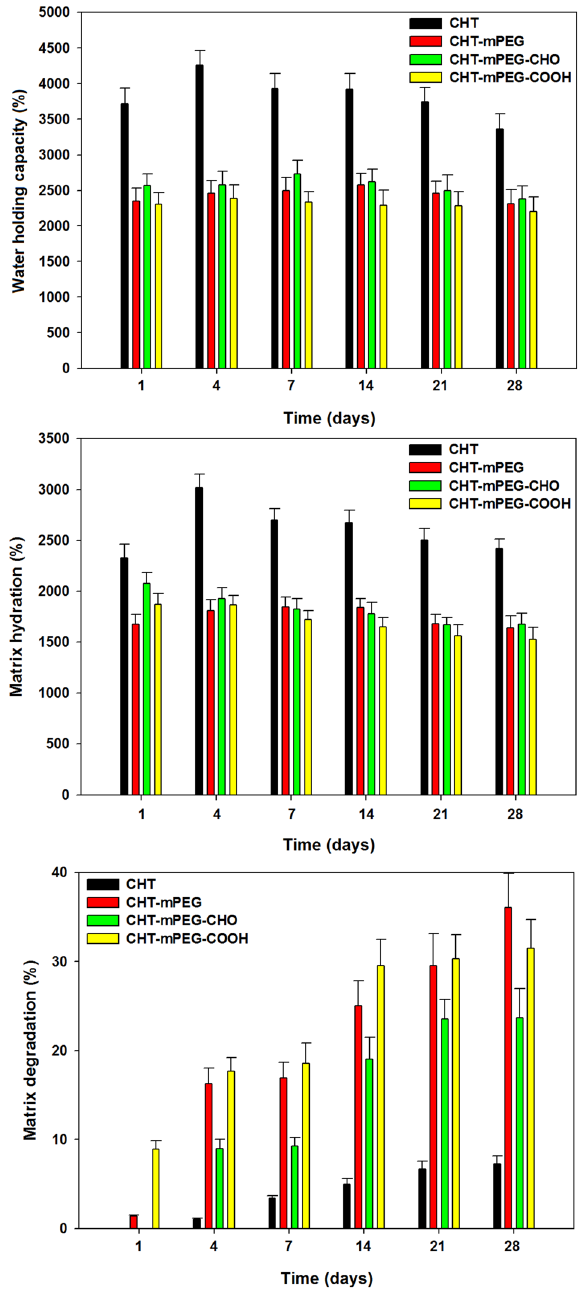
Figure 9. Bar charts depicting hydration and degradation profiles of various cryosponges (data represent mean ± std. dev. from 3 independent